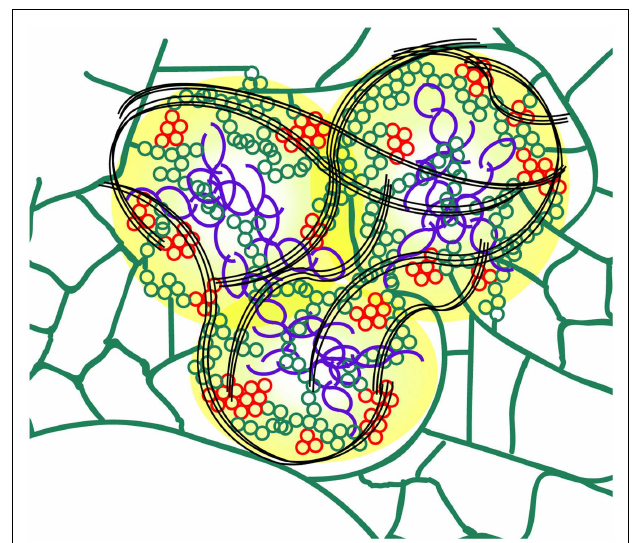
FIGURE 7 | Schematic model of the PVX X-body (not to scale). The TGB1 “beaded sheets” (purple) are localized in the center of the X-body. As shown previously, non-encapsidated vRNA (yellow) surrounds theTGB1 inclusions (Tilsner et al., 2009, 2012). Host ER (green) is remodeled into arrays of small membrane hoops byTGB2 which are wrapped around the TGB1 aggregates within the X-body. Some patches of theseTGB2 loops also containTGB3 (red) and may constitute the replication sites of the virus (Bamunusinghe et al., 2009). Bundles of encapsidated virions (black) accumulate at the periphery and form “cages” around the X-body